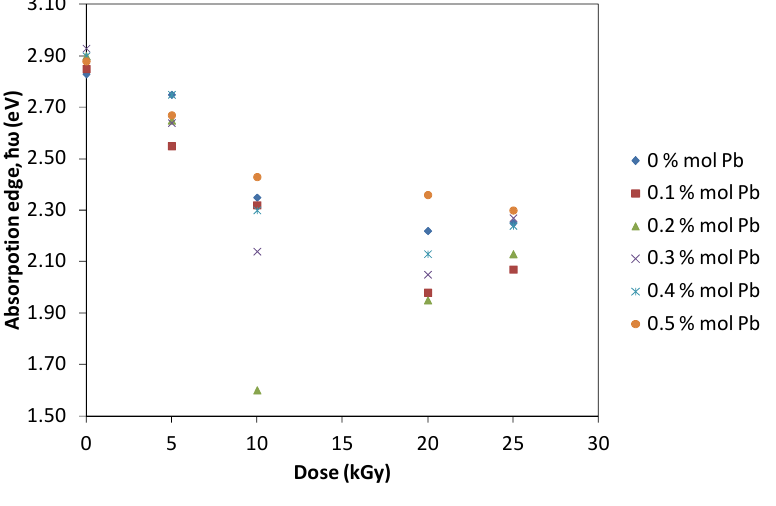
) [(PbO) (B O ) ] glasses with 2 y x 2 3 1 − x 1 − y